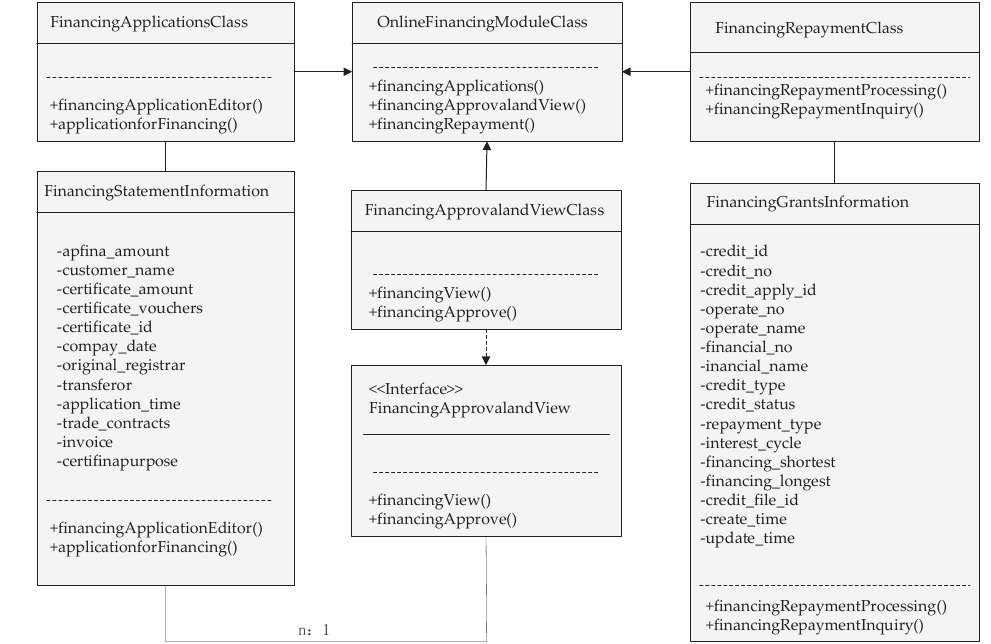
Figure 9. Class diagram of online financing